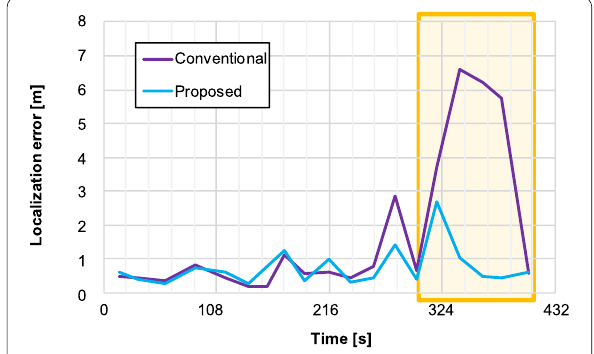
Fig. 7 Localization errors in Fig.